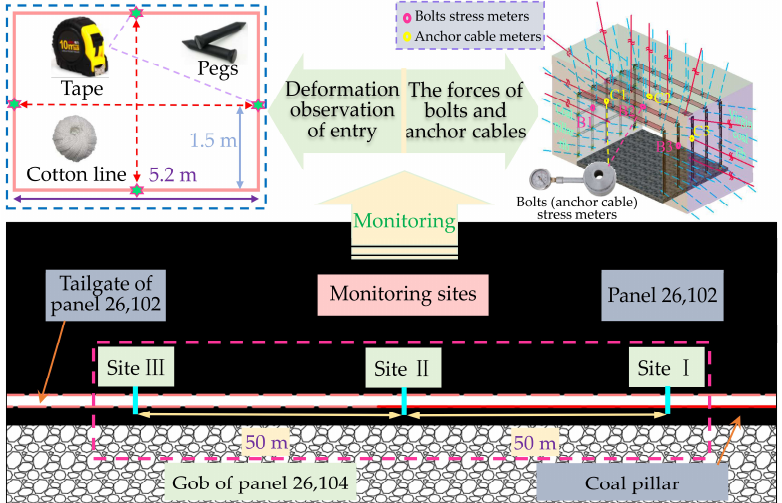
Figure 15. Layout of the field measurements.